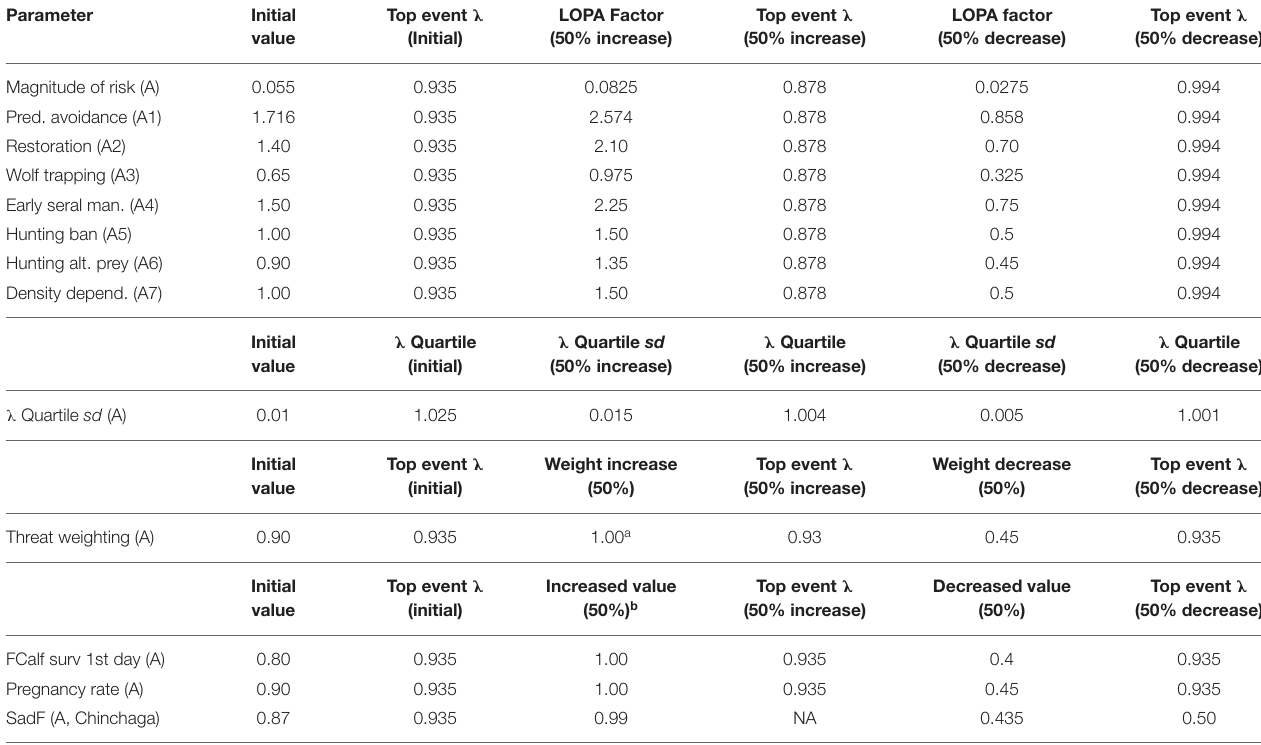
TABLE 4 | Sensitivity analysis for a BRAT framework quantifying risks to Woodland boreal caribou in Northeastern British Columbia, Canada.